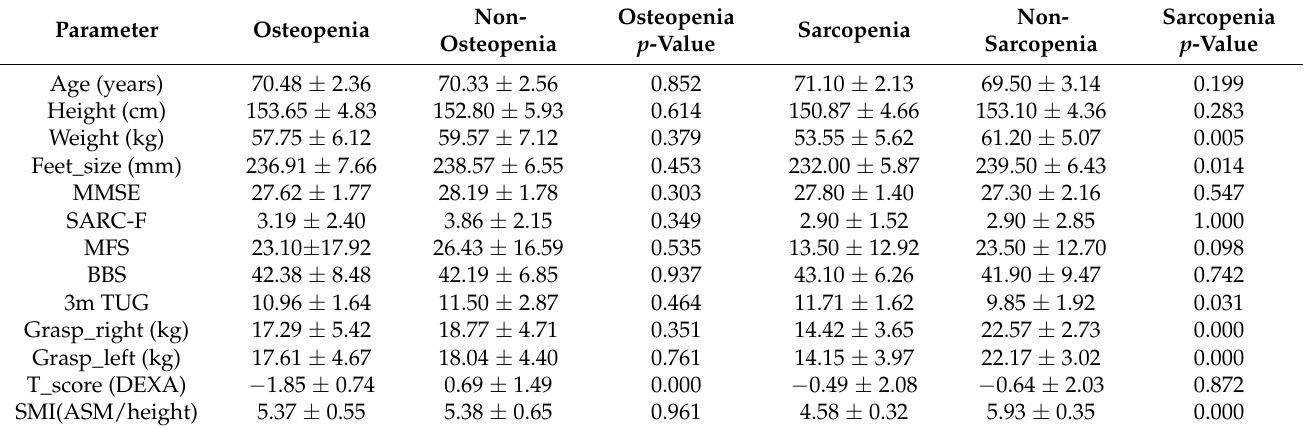
Table 2. Group population statistics for osteopenia and sarcopenia groups.